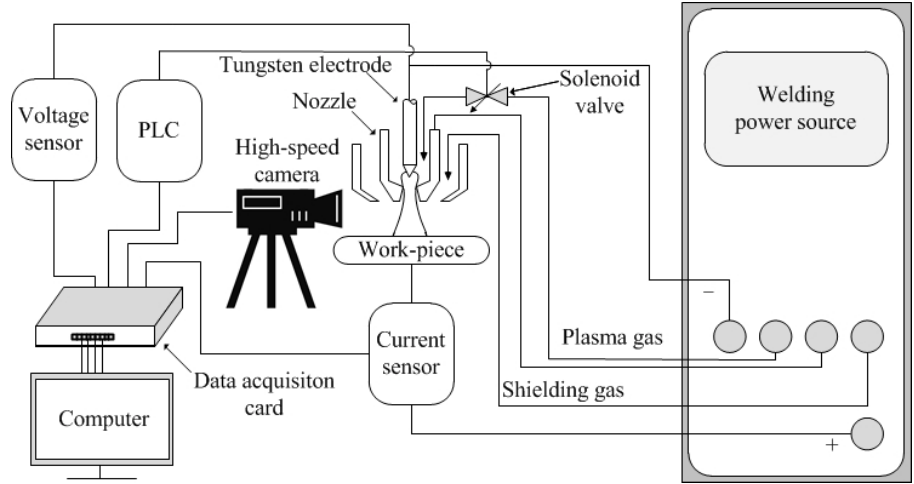
Figure 1. Schematic diagram of the PPG-VPPAW system.